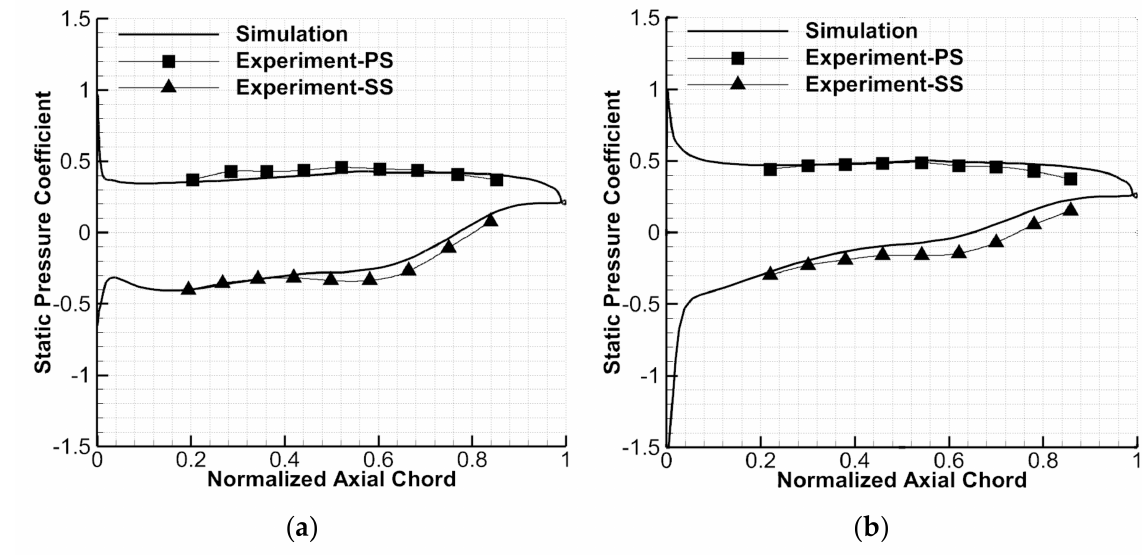
Figure 6. Comparison between the simulation and experimental results of the original cascade: ( a ) 0.5 ◦ ; ( b ) 5 ◦ .